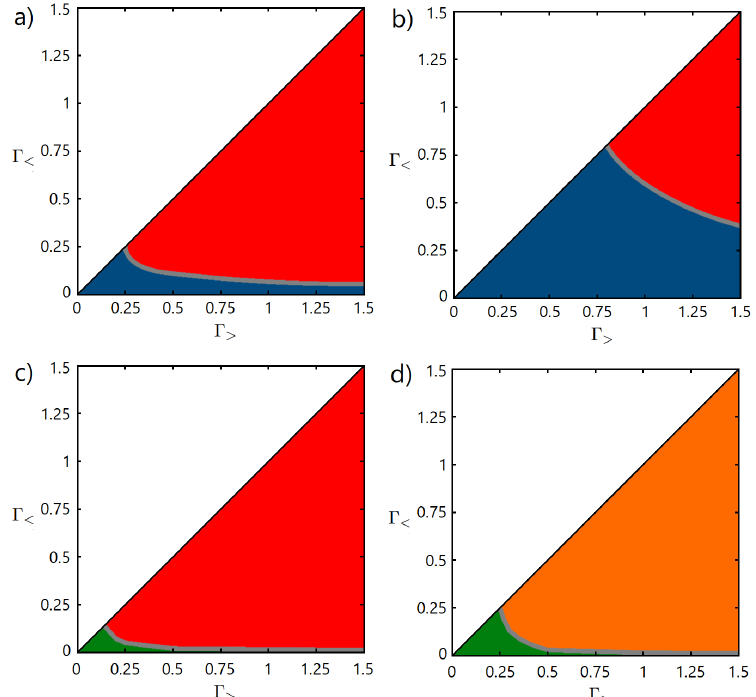
Figure 11: Panel a): Phase diagram of a three-way roundabout with two major fluxes, Γ ( 4 ) = Γ ( 5 ) = Γ Γ ( 6 ) = Γ γ and t Z symmetric. > , and a minor flux, < and with constants 3 At each point we plot which priority rule, between the wild one (blue region) and the perfect roundabout (red region), exhibits the higher current across the system. We assume a symmetry between incoming vehicles that want to exit at the first and second available exit by setting α ( (cid:96) ) = 0.5, with (cid:96) = 1,2,3. The other parameters are = 0.1, Γ ( (cid:96) ) = 0.5, γ ( (cid:96) ) = 3. Panel b): Same as panel a) but with an set to t ( (cid:96) ) = 1, γ C j asymmetry in the exit direction that favors the first available gate, α = 0.75. Panel c): Same as panel b) but now we compare the right-hand priority rule (green region) and the perfect roundabout ( β = 1 one (red region). Panel d): Same as panel b) but now we compare the right-hand priority rule (green region) and the no-turn signal roundabout ( β = 0 one (orange